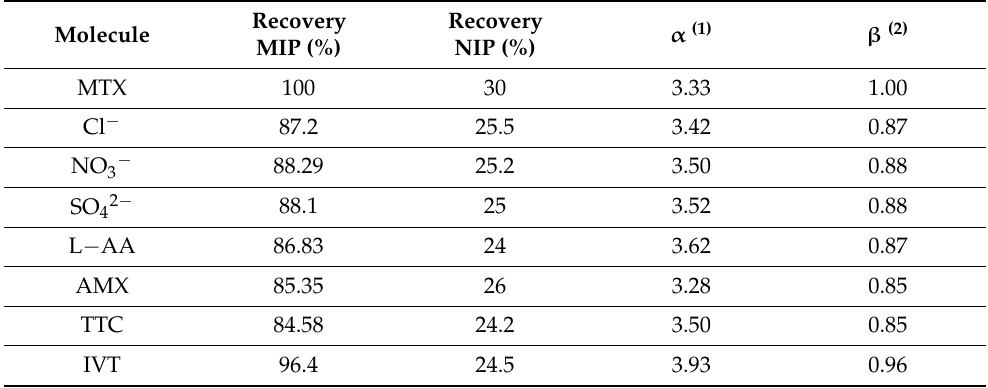
Table 1. Results obtained from the analysis of selectivity of MIP/MWCNT/GCE and NIP/MWCNT/GCE in terms of the quantification of methotrexate in the presence of interfering molecules.